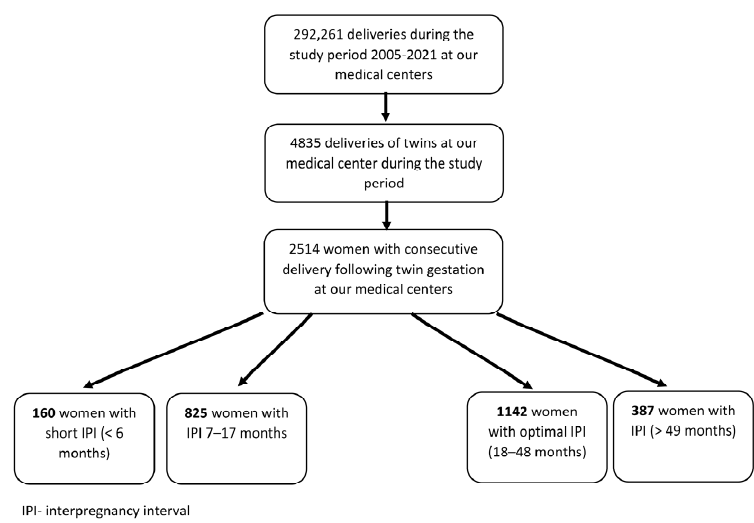
Figure 1. Flow chart of the study cohort.